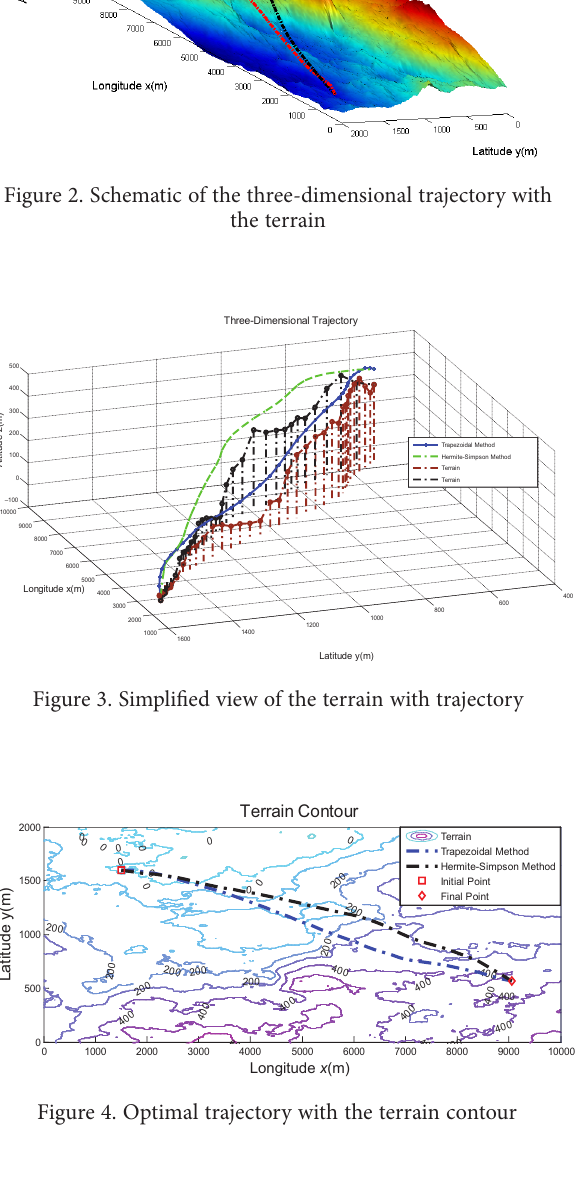
Figure 8. History of the throttle controller